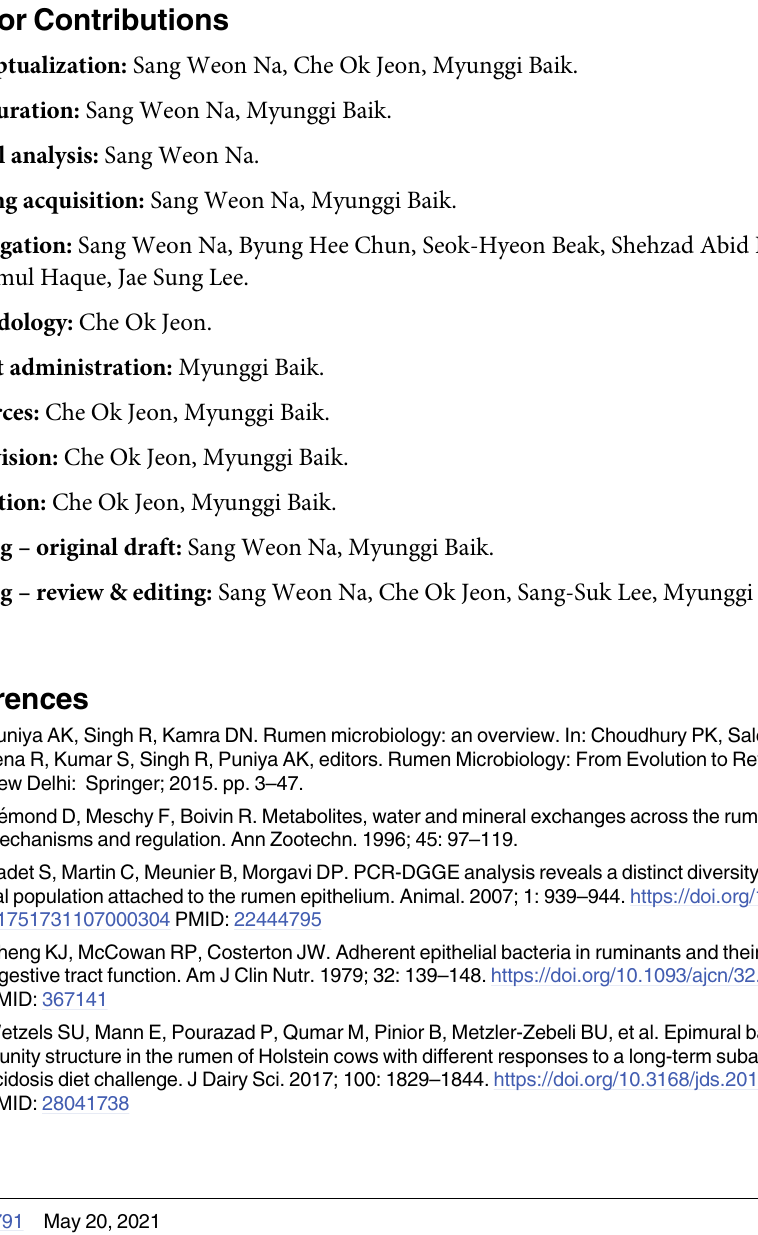
S5 Fig. Profiles of galactose, N -acetylglucosamine, and mannose in the mucin-glucose (A) and basal mucin (B) media during fermentation. Data are presented as mean ± standard error from triplicates. S6 Fig. Profile of major amino acids in the mucin-glucose (A) and basal mucin (B) media dur- ing fermentation. Data are presented as mean ± standard error from triplicates. S1 Dataset. Genome features of Pseudoprevotella muciniphila E39 T